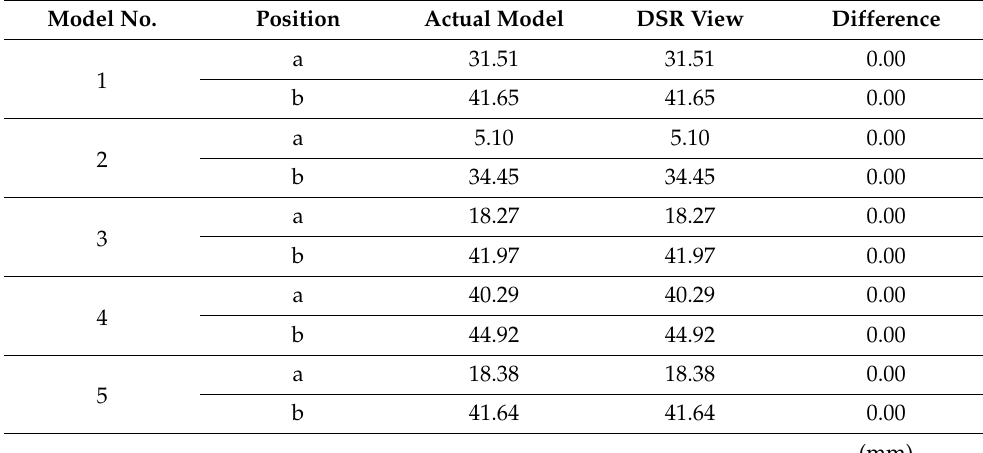
Table 3. Measurement results in the horizontal direction.